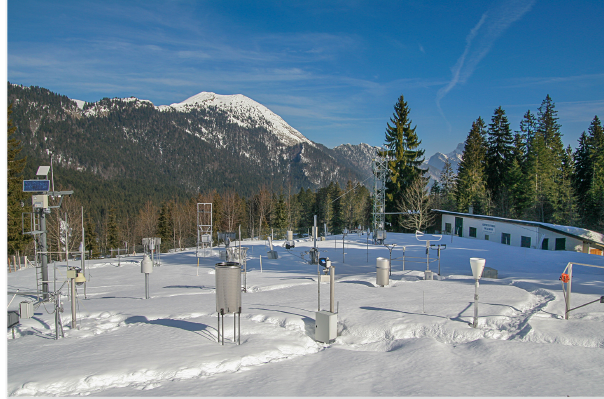
Figure 1. Picture of the site taken on 10 March 2014 from the south barrier, looking towards